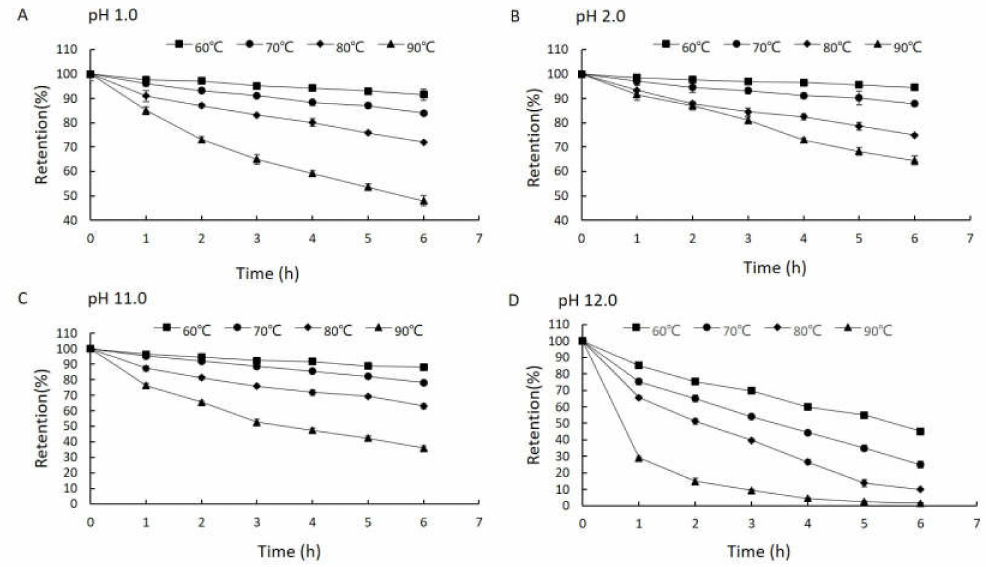
Figure 2. The residues of Neu5Ac solution after various heating temperatures, times and pH